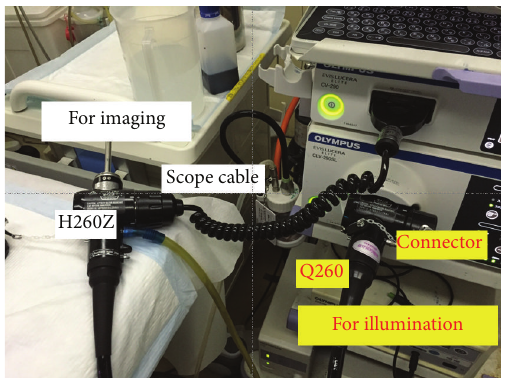
Figure 2: Connection method of the